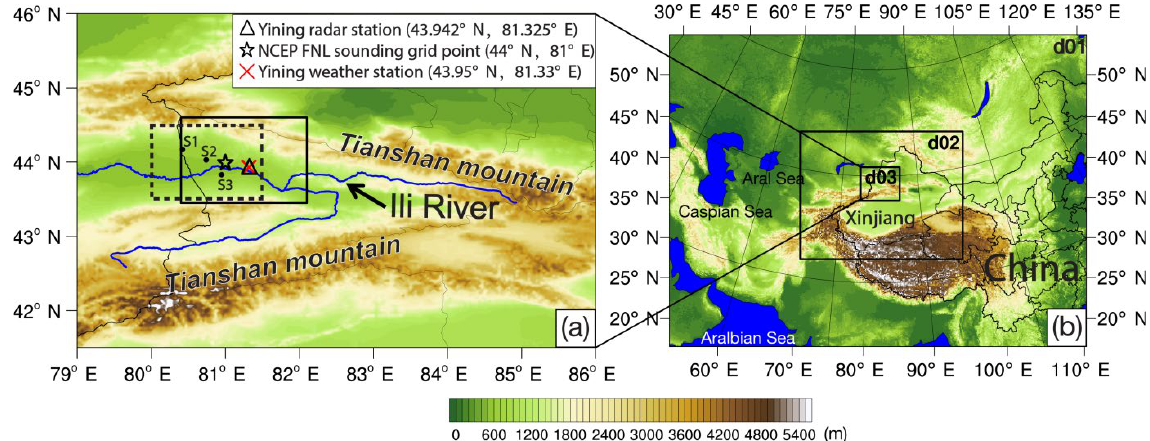
Figure 1. ( a ) Geographic location and terrain altitude (shading, unit: m) of the study area where the severe convective storm occurred. The solid rectangle area denotes the area which will be analyzed in Figures 3, 7 and 8. The dashed rectangle area shows upstream area which will be analyzed in Figures 9 and 10. The black dots indicate the locations of the ground-based automatic weather stations (S1, S2, and S3) mentioned in Figure 4. The solid black and gray lines indicate the national and district boundaries, respectively. ( b ) Geographic locations of the WRF model domains. The innermost domain (d03) covers the whole area shown in ( a ).